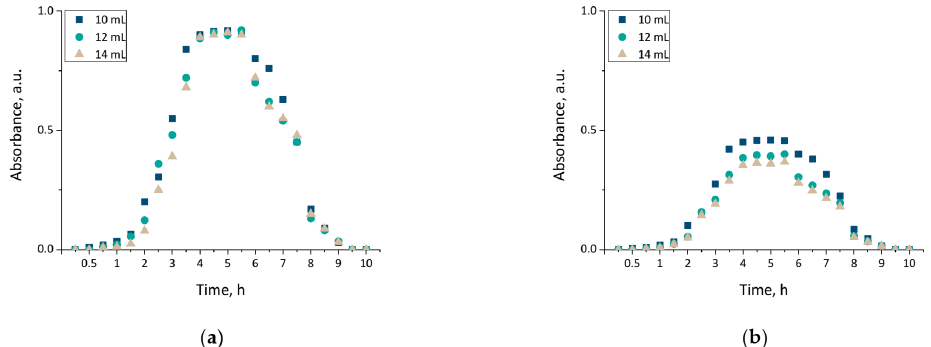
Figure 8. The release profiles of materials modified with Equisetum arvense L. extract determined in 2% citric acid solution ( a ) and phosphate buffer ( b ).